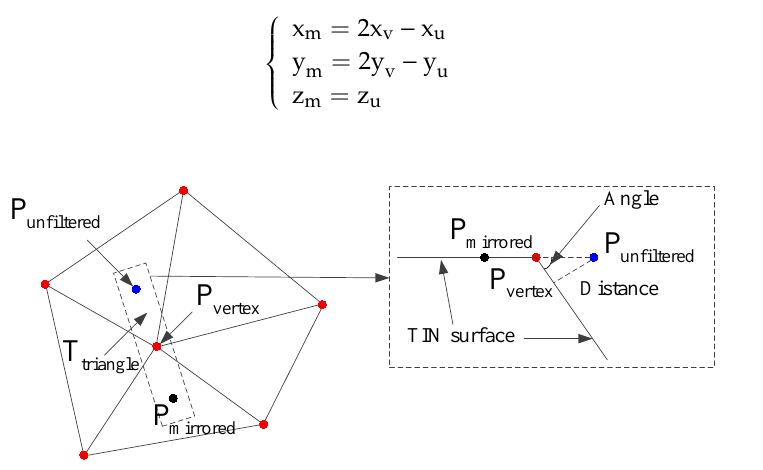
Figure 12. Mirrored operation.